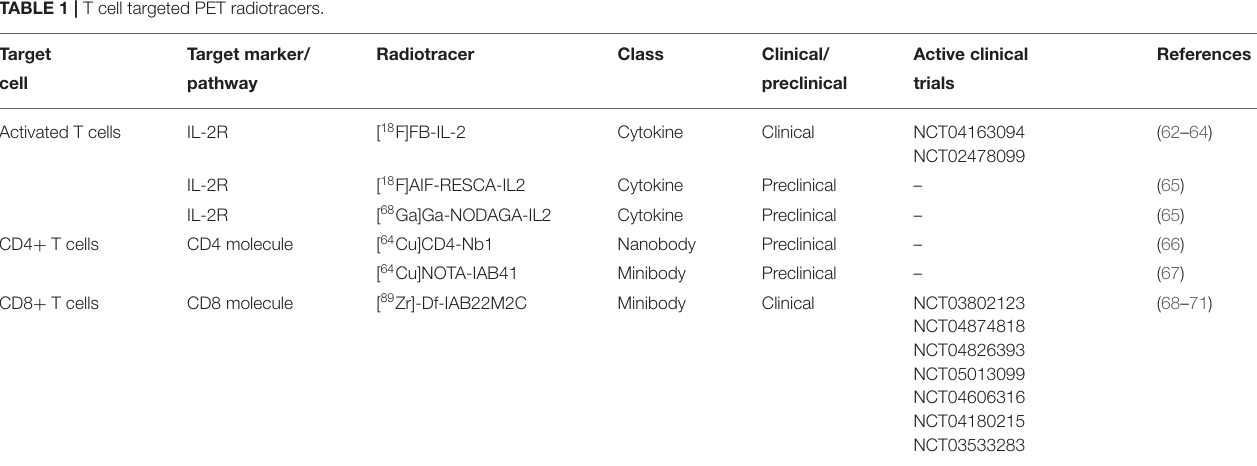
TABLE 1 | T cell targeted PET